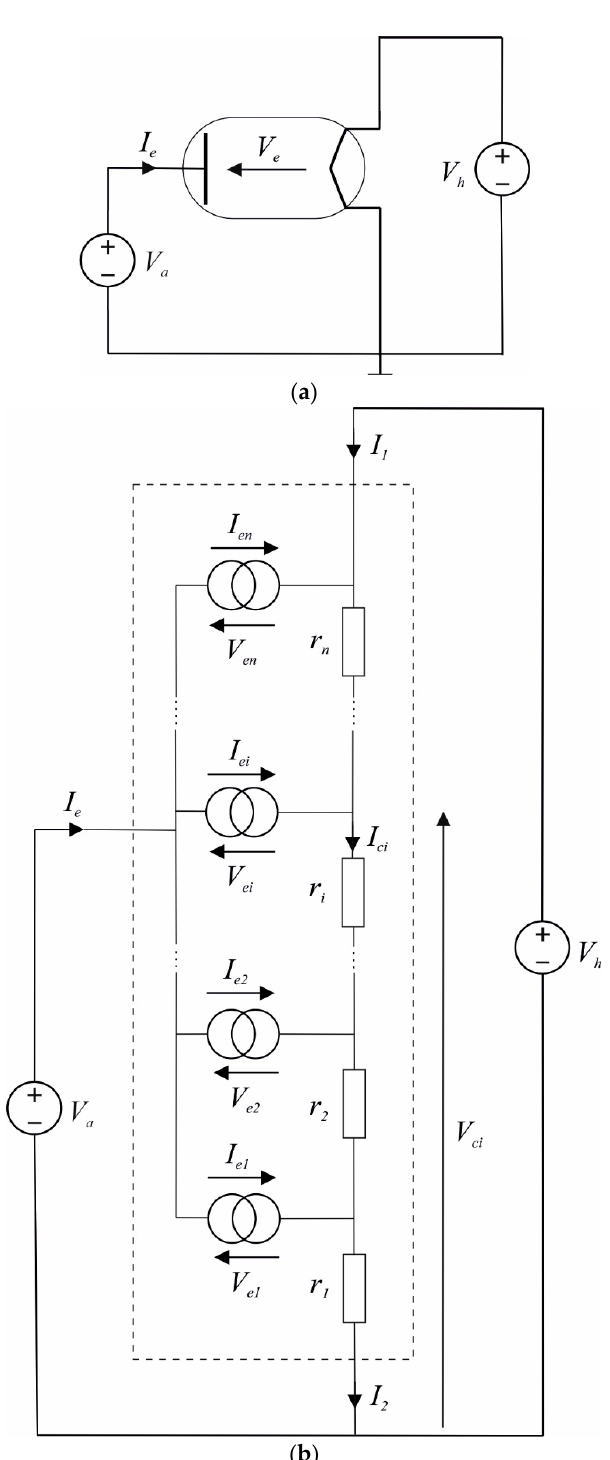
Figure 1. ( a ) Scheme of the thermionic electron source biasing system. V a is the anode voltage, I e is the thermionic emission current intensity, V e is the electron accelerating voltage, V h is the cathode heating voltage. ( b ). Simplified equivalent circuit of a thermionic electron source is inserted inside the dashed rectangle in place of the electron source. I 1 , I 2 are the boundary values of the intensity of the cathode current. The cathode is divided into n elementary parts with the resistance values r 1 , r 2 , …, r n , which at a fixed value of the heating voltage V h give an emission current with the intensity